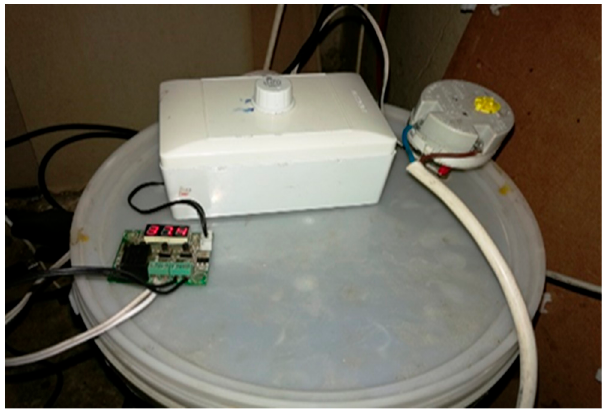
Figure 9. Hybrid geyser that was prototyped using 10-L water bucket, light dimmer, thermostat and the temperature